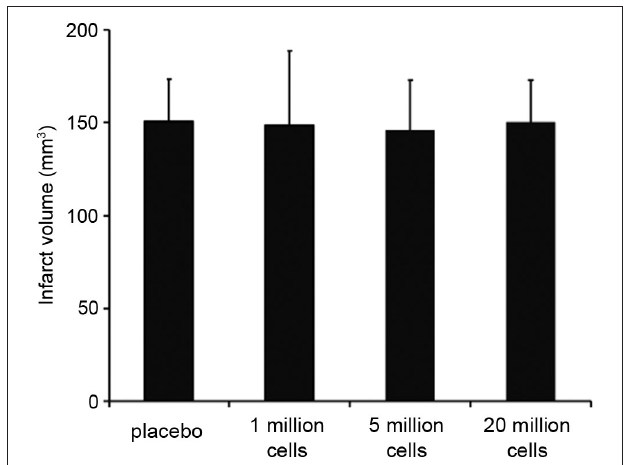
FIGURE 1 | Infarct volumes 3 days after transient MCAO . Infarct volumes did not differ between the four groups ( n = 15–16/group). P = 0.595.